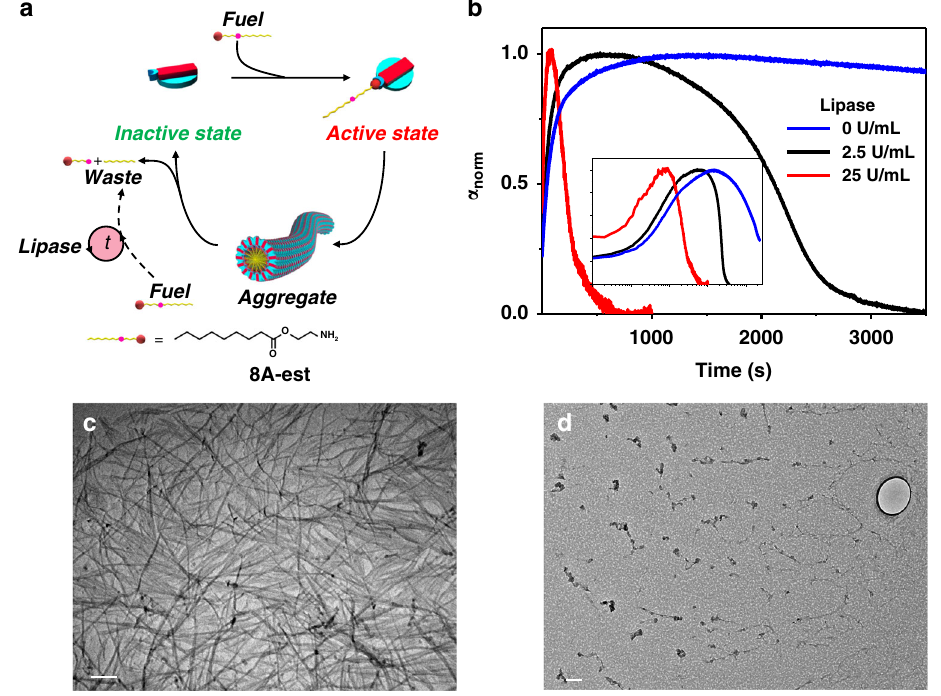
Fig. 5 Inherent transience in supramolecular polymerization. a Schematic representing the prospective inherent transient self-assembly affected by lipase. b Temporal pro fi le of 1.2-8A-est growth at various concentrations of lipase ([ 1 ] = [ 2 ] = 1 mM, [ 8A-est ] = 2 mM, pH = 11). (Inset shows changes with time in log scale.) c , d Cryo-TEM images of 1.2-8A-est at 2, 24 h respectively. (pH = 11, [ 1.2 ] = 1 mM, [ 8A-est ] = 2 mM, [ Lipase ] = 0 U/ml). Scale